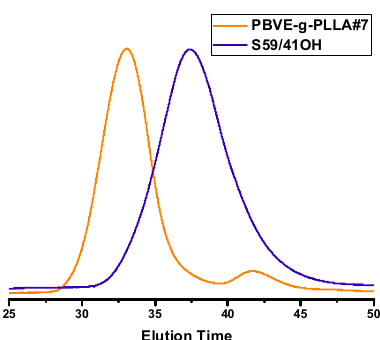
Figure 8. Monitoring the synthesis of sample PBVE– g –PLLA #7 via the grafting “from” methodology by SEC.